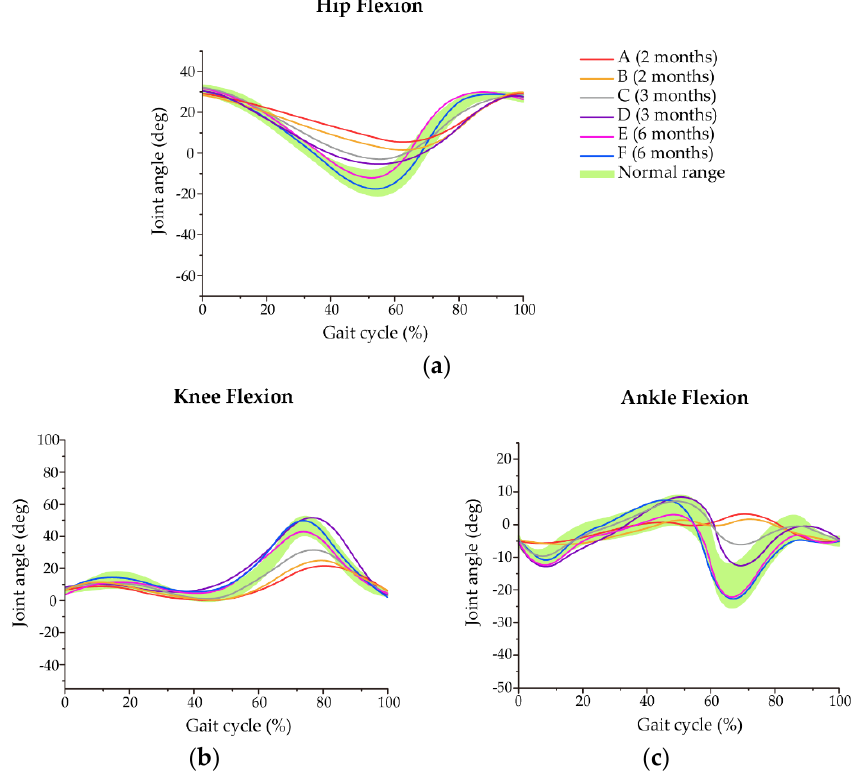
Figure 7. The angle curves of patients in three di ff erent rehabilitation periods and the comparison with normal ranges: ( a ) The hip flexion curves of the patient group during one gait cycle; ( b ) The trend of knee joint angle curves of patients was approximately similar to that of the normal range; ( c ) Patients A and B showed significant di ff erences in their ankle curves from the normal range compared with other